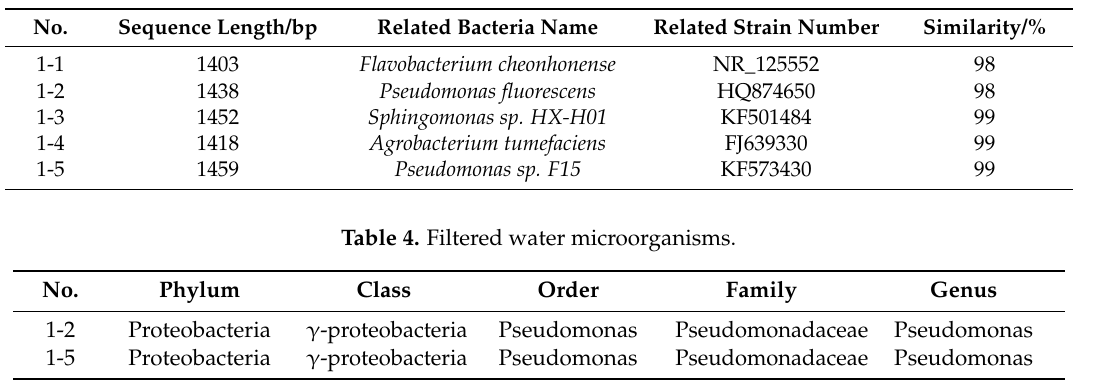
Table 4. Filtered water microorganisms.